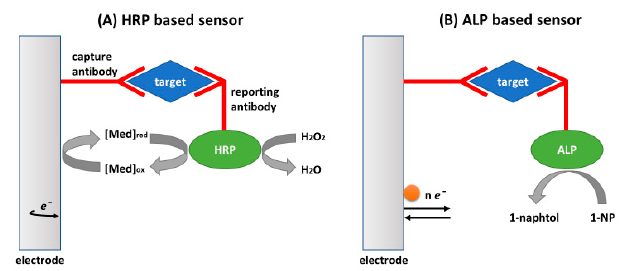
Figure 3. The scheme of the design of enzyme-based immunosensors that involve ( A ) horseradish peroxidase (HRP) and ( B ) alkaline phosphatase (ALP). Partially adopted with from [36]. 2016 Else- vier.